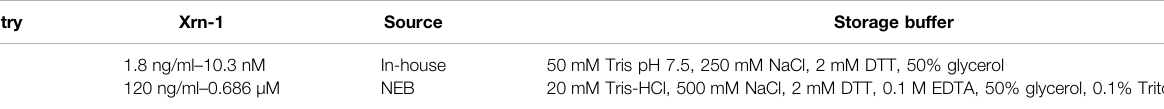
TABLE 2 | Exonuclease concentration and storage buffer for Xrn-1 used in this work. Entry